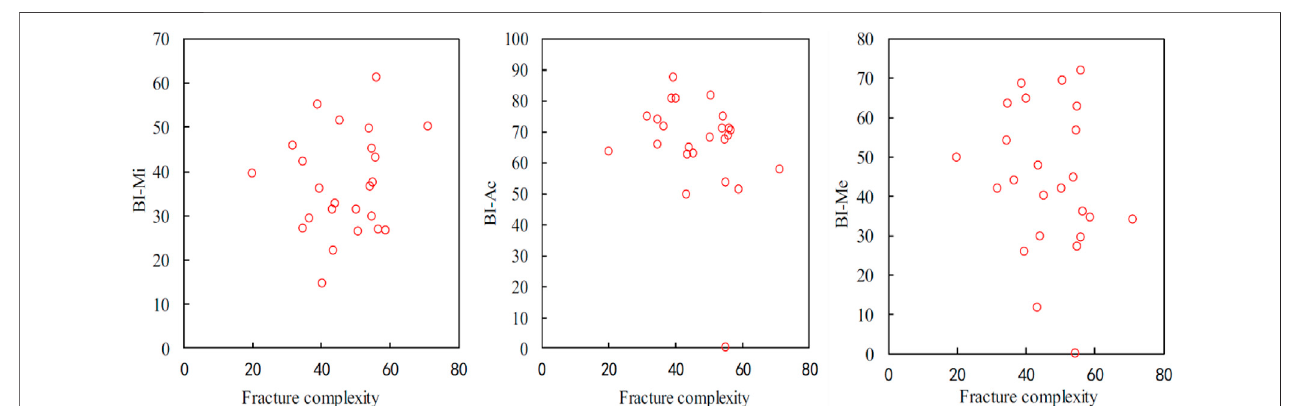
FIGURE 11 | Relationship between the brittleness index and fracture